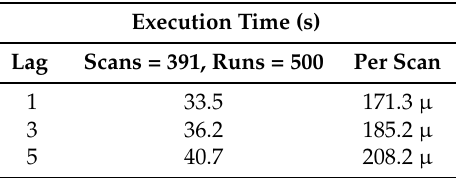
Table 2. Execution time of the A l 1 algorithm in a Nearest Neighbor (NN) filter framework for different lags.